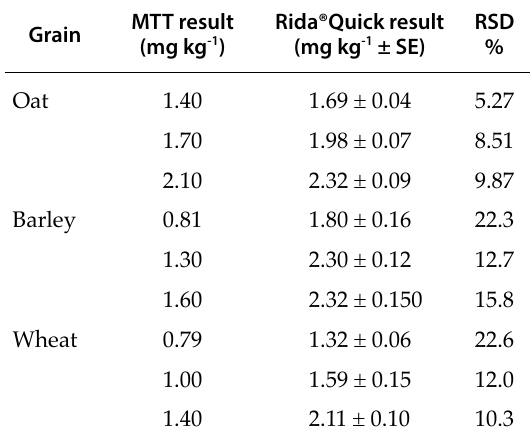
Table 1. The reproducibility of DON detection results (mean + SE of six DON extractions and DON measure- ments for each ground grain sample obtained from MTT) in oat, barley and wheat grain samples with three different DON